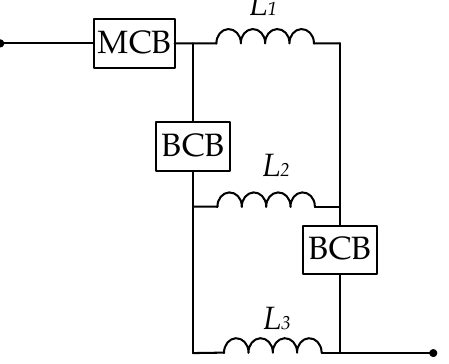
Figure 2. Fault-current-limiting circuit with MCB and BCB.